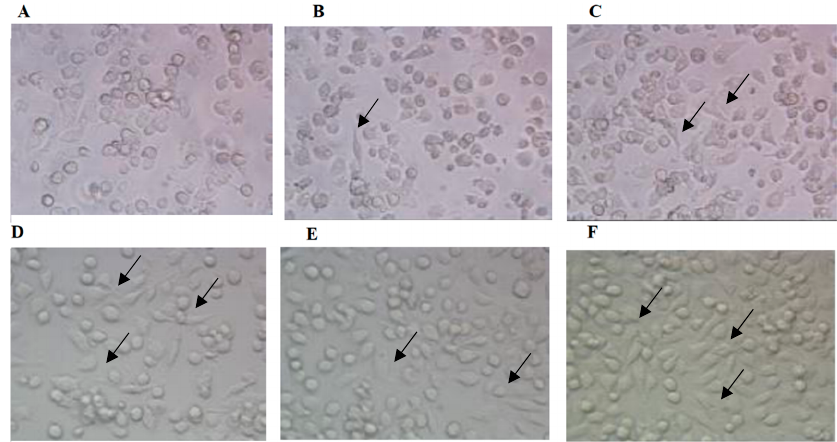
Figure 3. Morphological changes of DCs stimulated by AEAR. Cells were treated with 0 μ g/mL ( A ), 10 μ g/mL ( B ), 100 μ g/mL ( C ), 200 μ g/mL ( D ), and 400 μ g/mL ( E ) AEAR or 100 ng/mL LPS ( F ) for 24 h. The morphological changes were observed under an inverted microscope (400×).